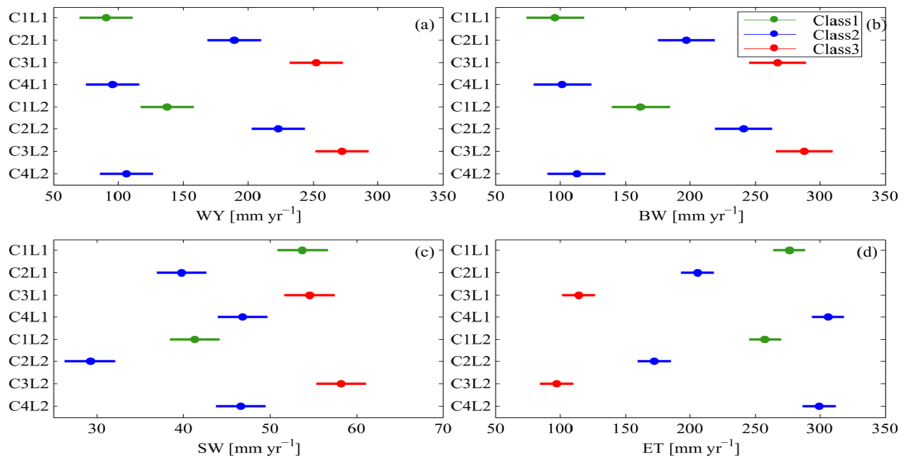
Figure 7. Range of four water resources components; ( a ) WY = water yield; ( b ) BW = blue water; ( c ) SW = soil water; ( d ) ET = evapotranspiration obtained from eight calibrated configurations during the studied period. The three colors identify configurations with high (Class1: green), medium (Class2: blue), and low (Class3: red) performance in simulating discharge values as displayed in Figure 4b